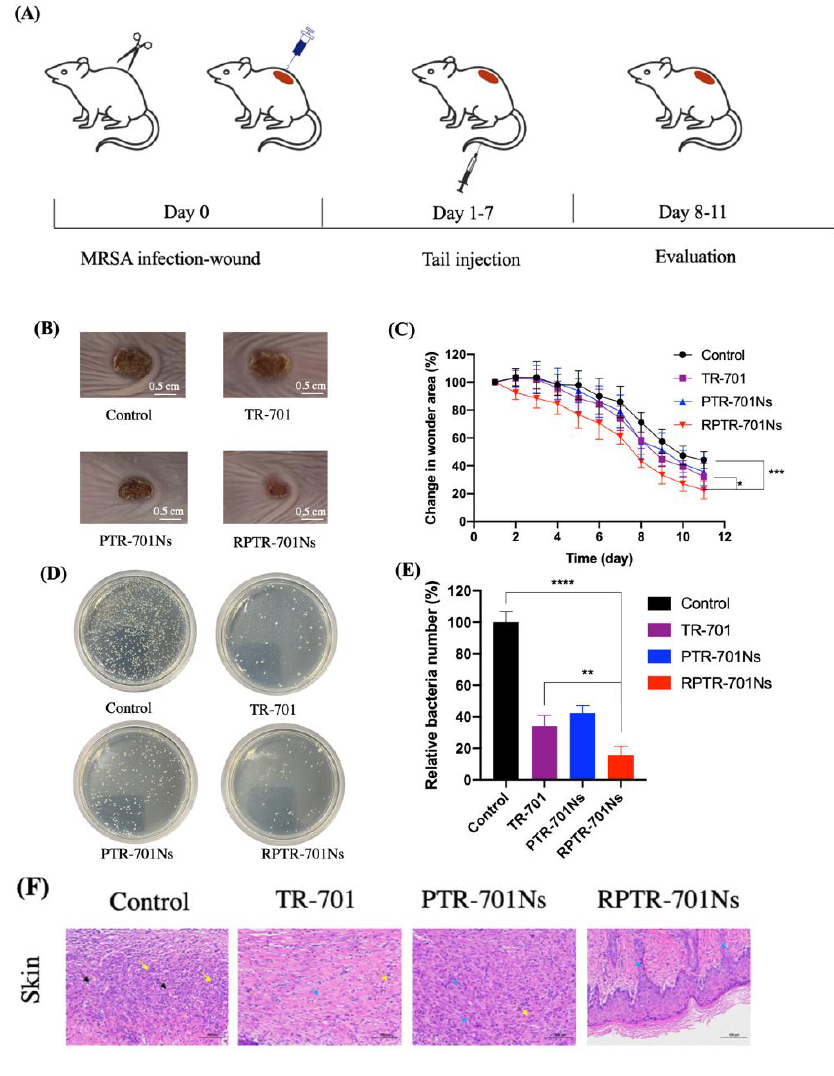
Figure 10. In vivo anti-bacterial efficacy of the formulations in MRSA-infected wound beading Balb/C mice. ( A ). Schematic diagram of MRSA-infected model establishment and treatment plan. ( B ) Photos of wound skin after treated with PBS, TR-701, PTR-701Ns and RPTR-701Ns. ( C ) Relative change in the wound area, n = 6. ( D ) LB culture pates of different groups of skin. ( E ) Quantitative analysis of bacteria colony, n = 4. ( F ) H&E staining of wound skin. Data were presented as mean ** p < 0.01, **** p < 0.0001.